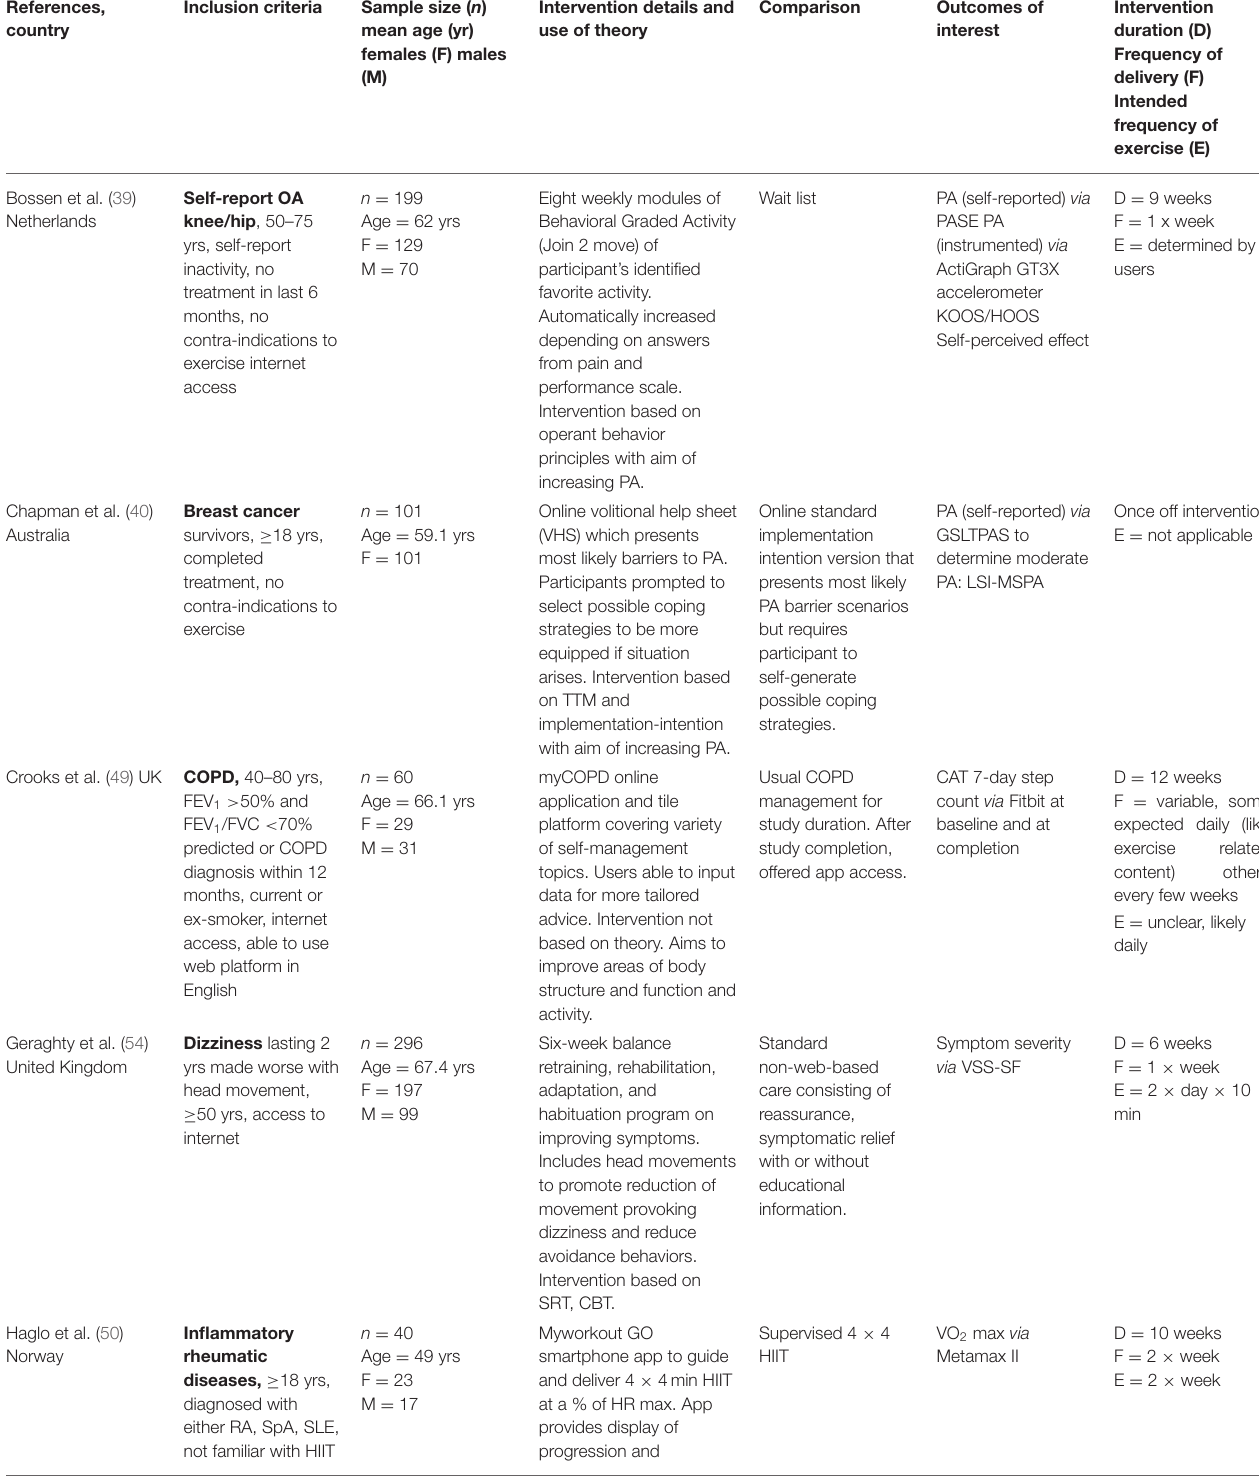
TABLE 3 | Characteristics of the randomized controlled trials, participants, and